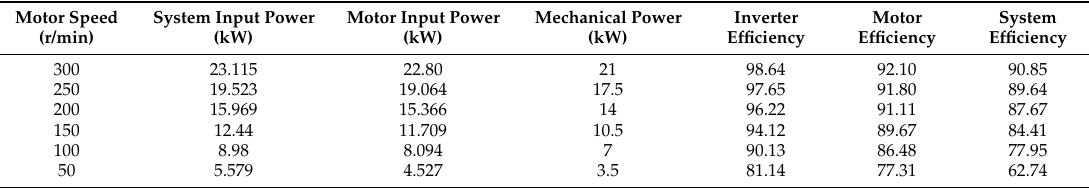
Table 10. Experimental results of the SiC-MOSFETs-based PMSM drive system at rated torque in the system efficiency improvement control.